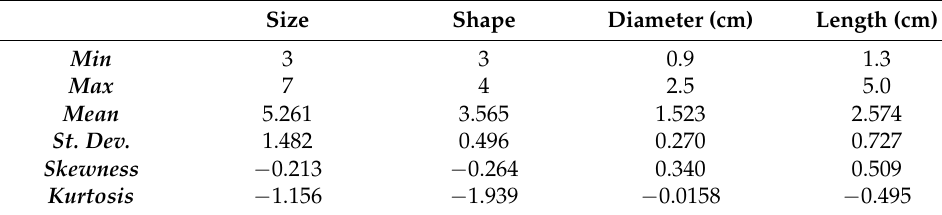
Table 4. The statistical characteristics of the studied traits in hops plants.